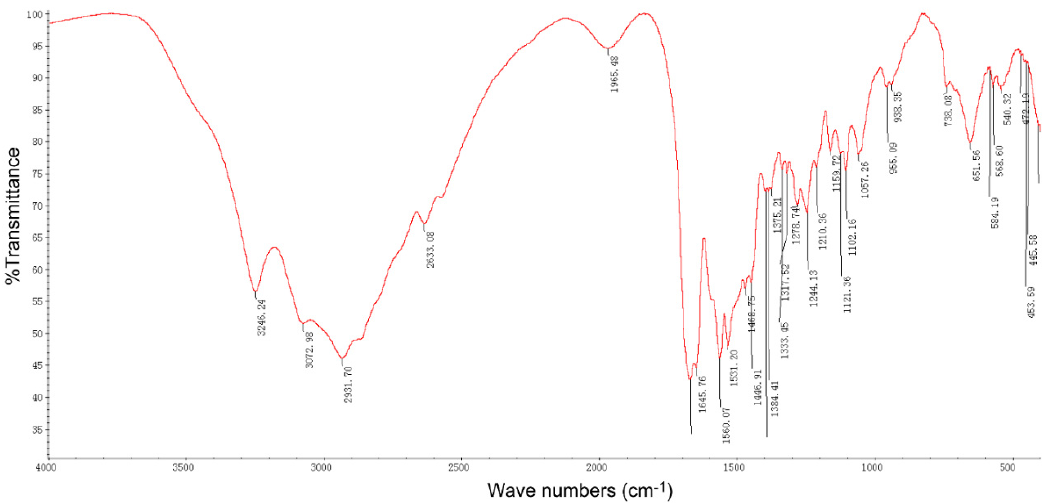
Figure 3. IR spectrum of the pure active compound isolated from Streptomyces STZ.